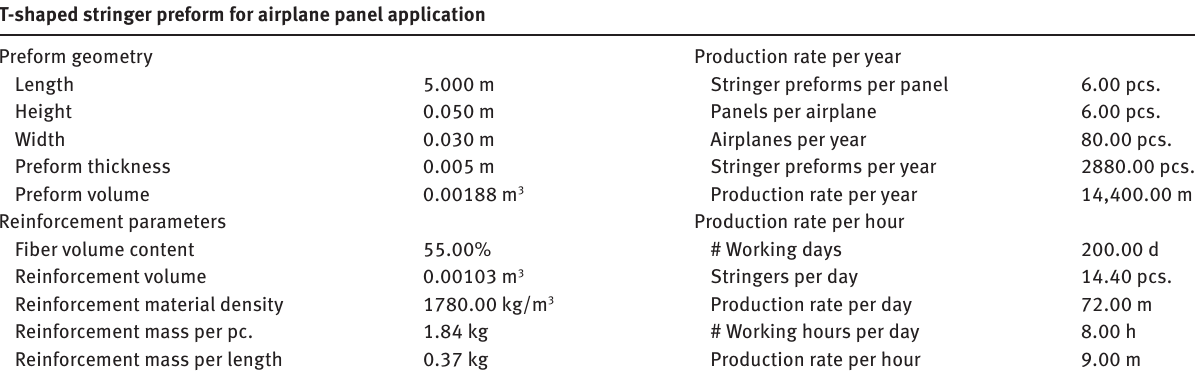
Table 1: Parameter list for an application scenario for automated manufacturing of T-shaped stringer preforms. T-shaped stringer preform for airplane panel